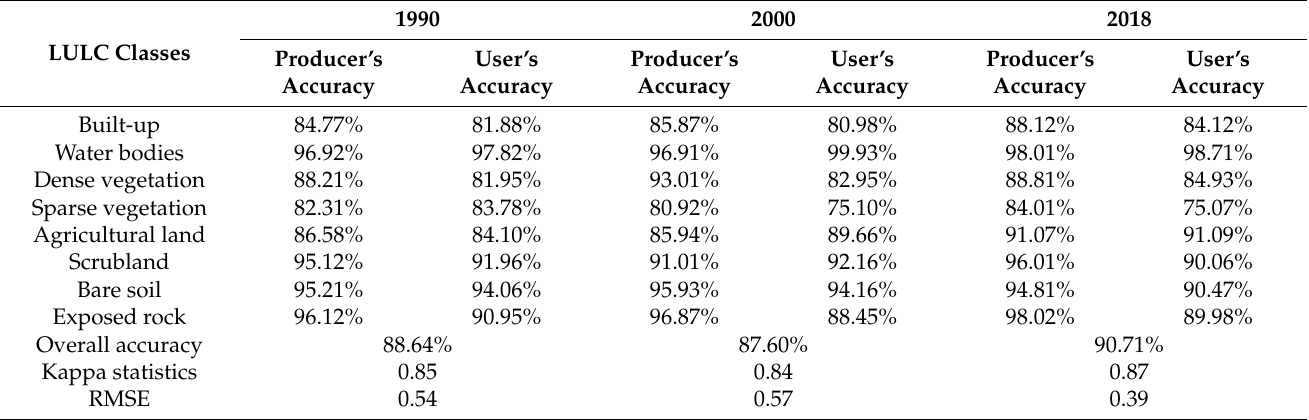
Table 2. Validation of LULC maps of 1990, 2000, and